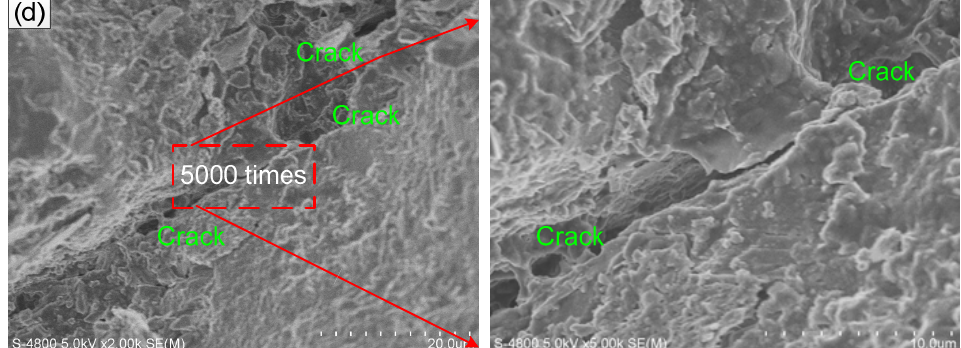
Figure 7. SEM pictures with magnification of 2000 × and 5000 × for granite ( a – d ); the numbers of F–T cycles are 0, 40, 60 and 80, respectively.